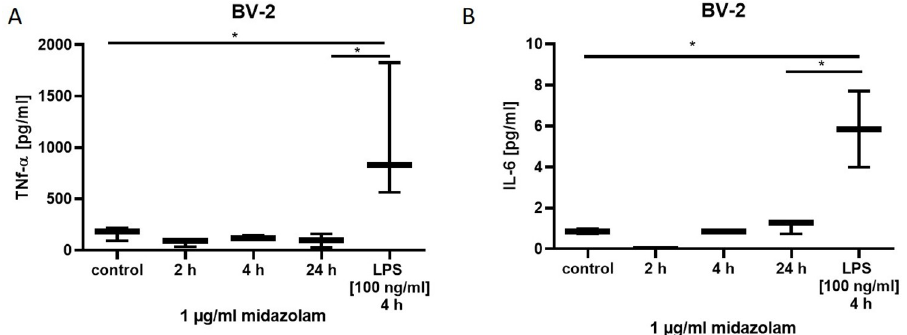
Fig 5. Cytokine secretion in BV-2 glial cells after midazolam (1 μ g/ml) for 24 hours and LPS (100 ng/ml) for 4 hours (n = 3). BV-2 cells were incubated with midazolam (1 μ g/ml) or lipopolysaccharide LPS (100 ng/ml) or left untreated. Cytokine expression was quantified using a bead-based immunoassay. Data are presented as mean ± standard deviation. The reported p-value refers to the Dunnett’s post-hoc test, comparing the underlying columns at the ends of each